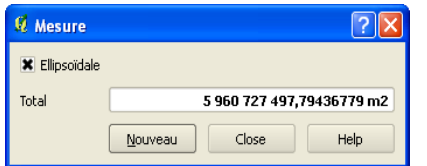
Figure 13: Measurement tool of Quantum GIS 1.7.2 software, allowing the computation of ellipsoidal length and